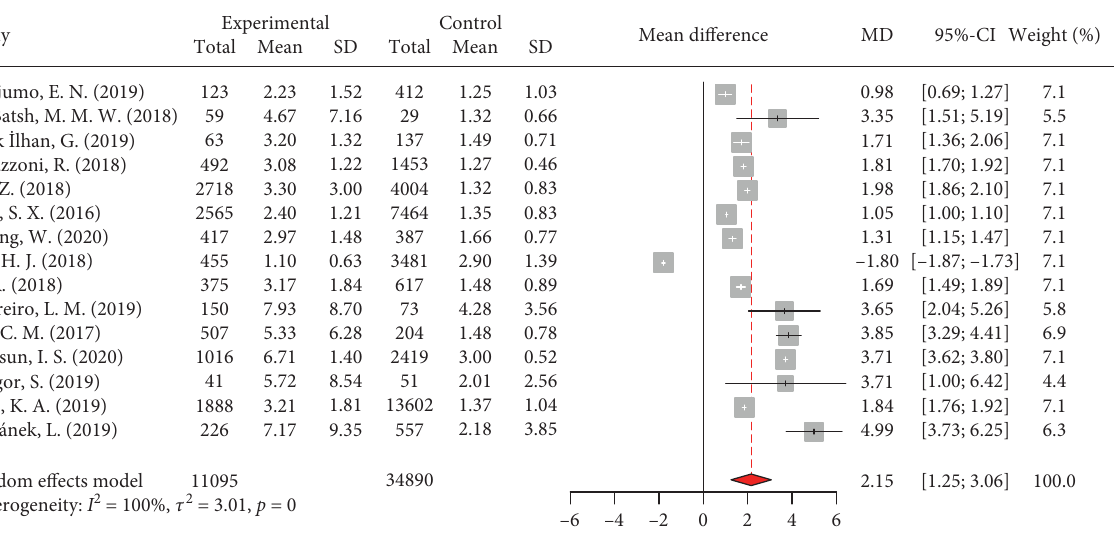
Figure 4: Forest plot of pooled differences in mean of visceral adiposity index between patients with metabolic syndrome and healthy controls.